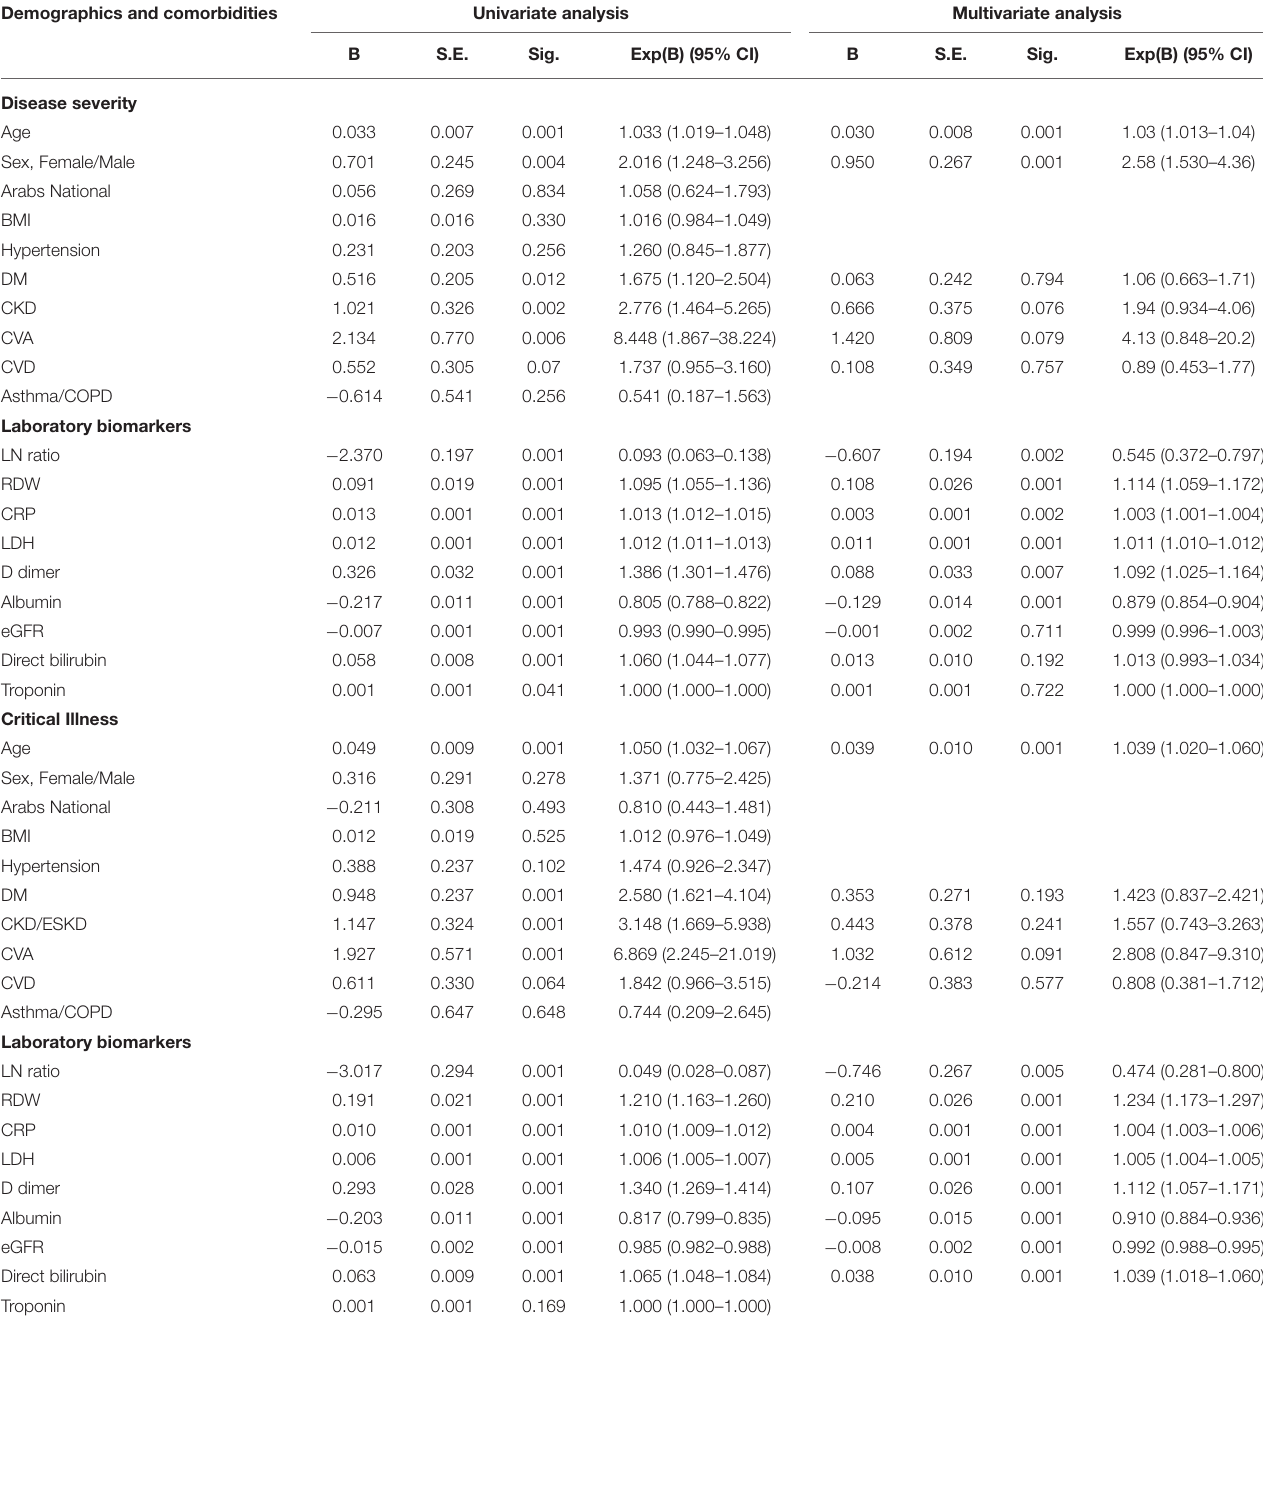
TABLE 1 | Univariate and multivariate regression analysis of predictive factors of severe COVID-19, critical illness, and in-hospital mortality. Demographics and comorbidities Univariate analysis Multivariate